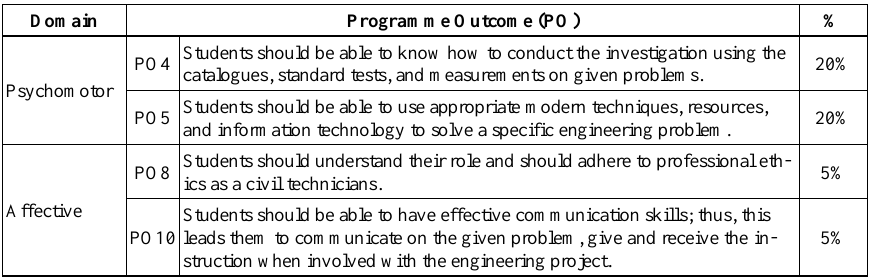
Table 3. Mapping of Pos with the psychomotor and affective domain